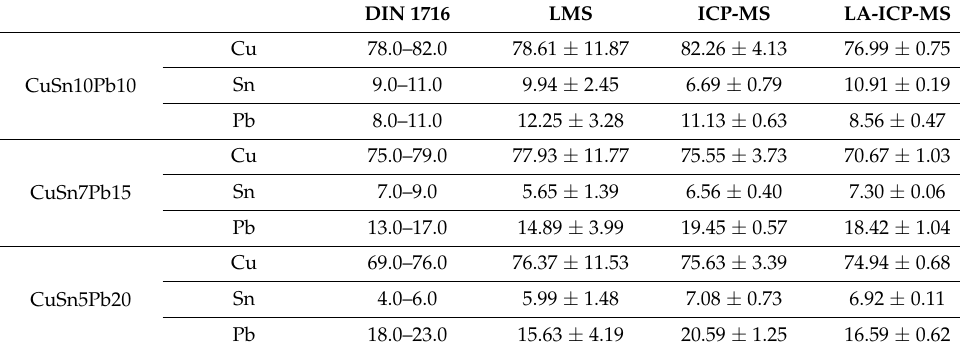
Table 3. Summary of composition measurements for three Cu-Sn-Pb alloy samples obtained by LMS, ICP-CRI-MS, and LA-ICP-MS techniques. Abundances and errors are given in wt%